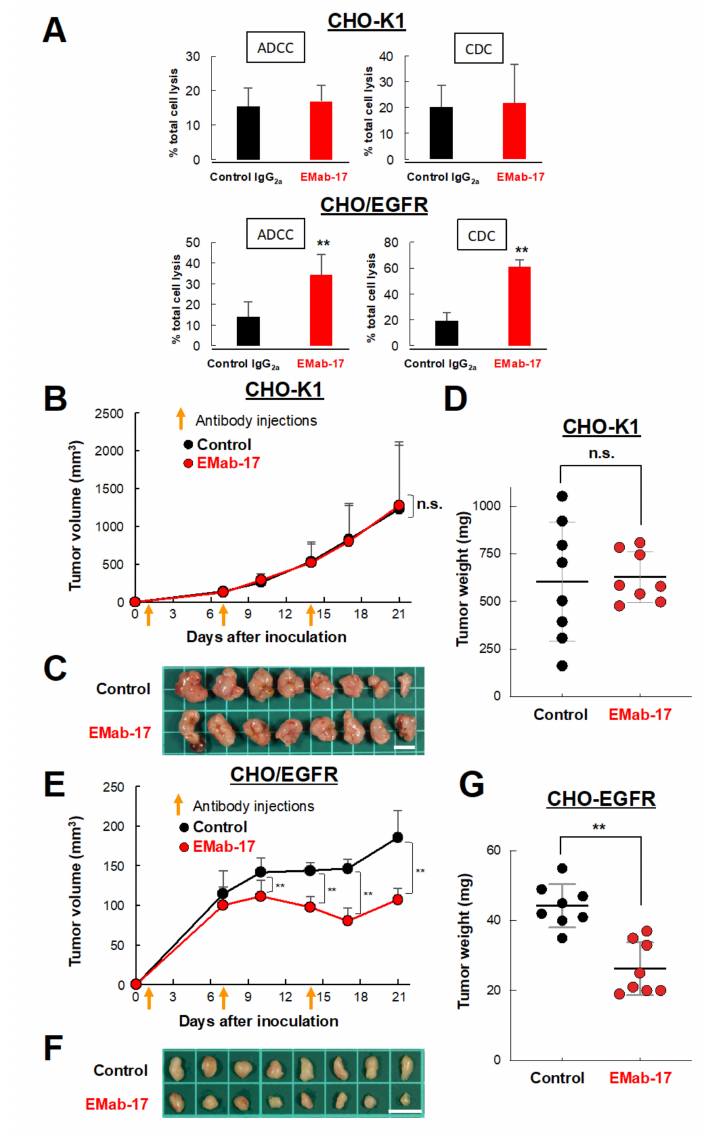
Figure 2. Antibody-dependent cellular cytotoxicity (ADCC), complement-dependent cytotoxicity (CDC) and anti-tumor activities of EMab-17 against CHO / EGFR cells. ( A ) ADCC ( Left ) and CDC ( Right ) activities of EMab-17 against CHO-K1 ( Top ) or CHO / EGFR ( Bottom ) in vitro. ADCC activity was evaluated through the calcein-AM release assay in the presence of antibodies (100 µ g / mL; e ff ector / target ratio, 50). CDC activity was determined using the MTS assay in the presence of antibodies (100 µ g / mL) or control mouse IgG 2a (100 µ g / mL) with 10% rabbit complement. **: p < 0.01 vs. IgG 2a -treated control. ( B , E ) Anti-tumor activity of EMab-17 against CHO-K1 or CHO / EGFR cells in vivo. Tumor volume of CHO-K1 ( B ) or CHO / EGFR ( E ) xenografts. Cells (5 × 10 6 cells / 100 µ L) were subcutaneously inoculated into BALB / c nude mice. After 1 day, 100 µ g of EMab-17 or control mouse IgG were injected into the peritoneal cavities of the mice. The orange arrows indicate the days of antibody injection and the antibodies were injected thrice (days 1, 7 and 14; control: n = 8; EMab-17: n = 8). The tumor diameter was measured at the indicated days and calculated using the formula: tumor volume = W 2 × L / 2, where W is the short diameter and L is the long diameter. Values are presented as means (SD). n.s.: not significant, **: p < 0.01 vs. control. ( C , F ) Resected tumors of CHO-K1 ( C ) or CHO / EGFR ( F ) xenografts on day 21. Scale bar: 10 mm. ( D , G ) Tumor weight of CHO-K1 ( D ) or CHO / EGFR ( G ) xenografts. Values are presented as means ± SEM. n.s.: not significant, **: p < 0.01 vs.